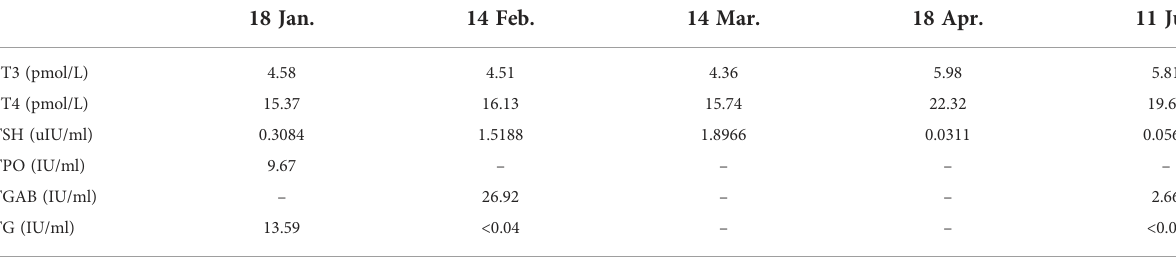
TABLE 1 The biochemical test results of the patient with thyroid cancer before and after surgery (20